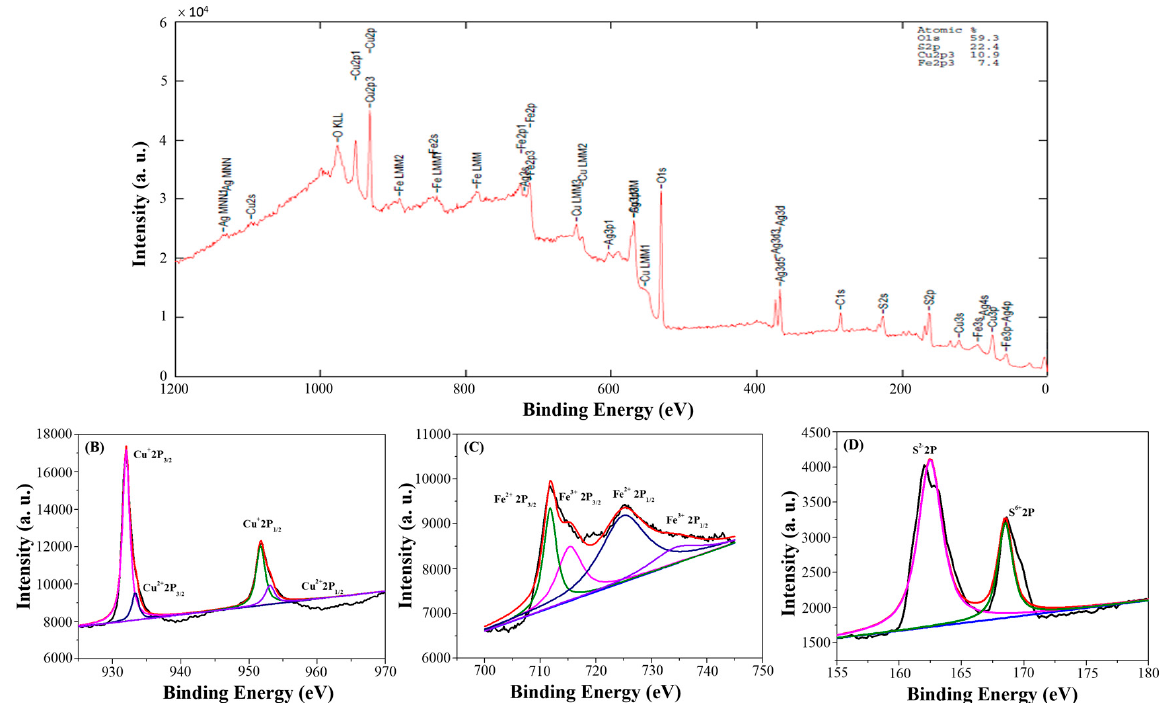
Figure 5. XPS spectra of H-CuFeS 2 samples: ( A ) full scan, ( B ) Cu 2p , ( C ) Fe 2p , and ( D ) S 2p .